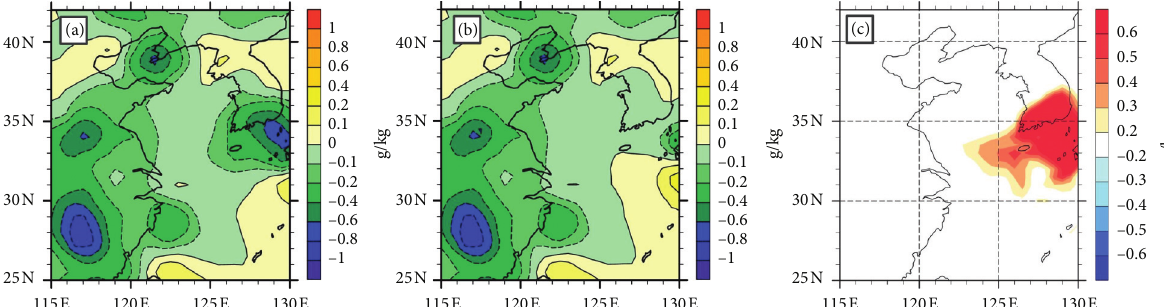
Figure 17: (a) Analysis increments of mixing ratio near the surface for Exp-B_CV5 (a) and Exp-B_CV5e (b) and differences in the initial mixing ratio between them (Exp-B_CV5e minus Exp-B_CV5) (c).